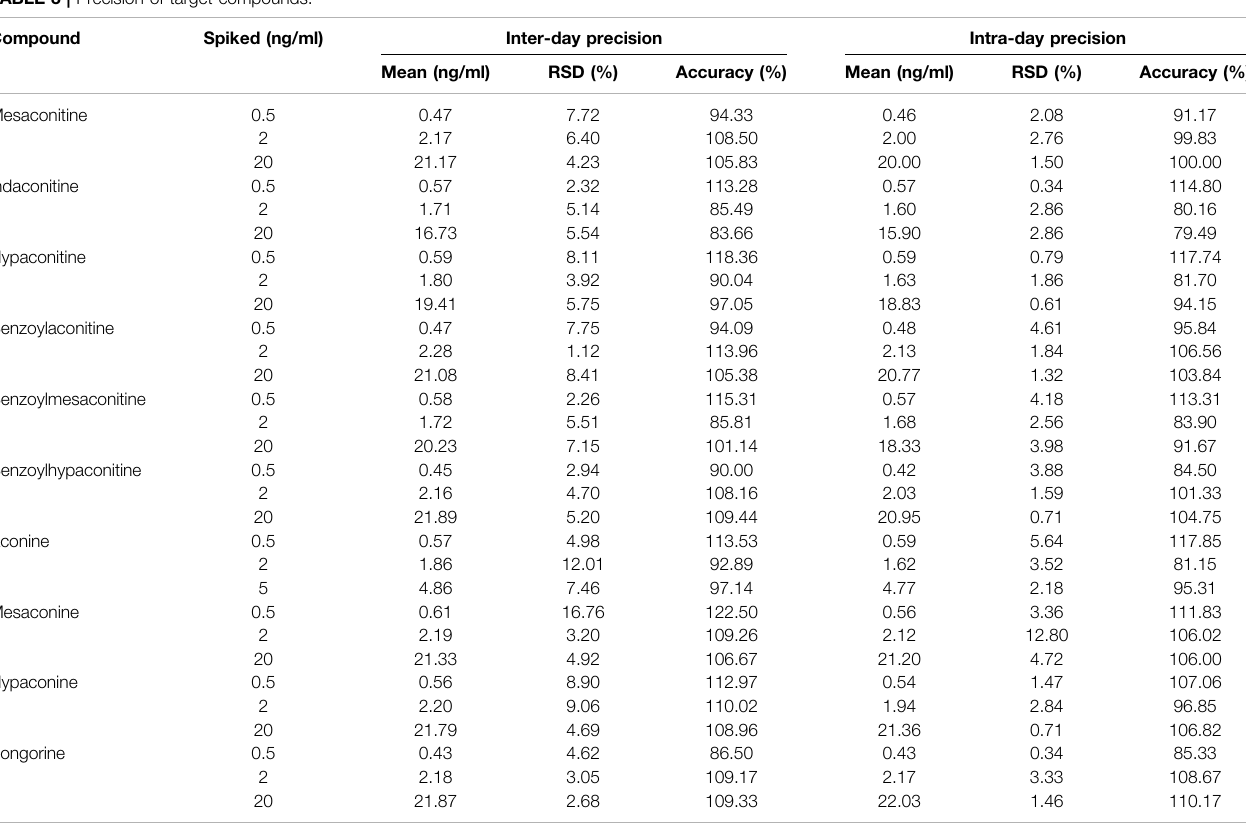
TABLE 3 | Precision of target compounds. Compound Spiked (ng/ml)